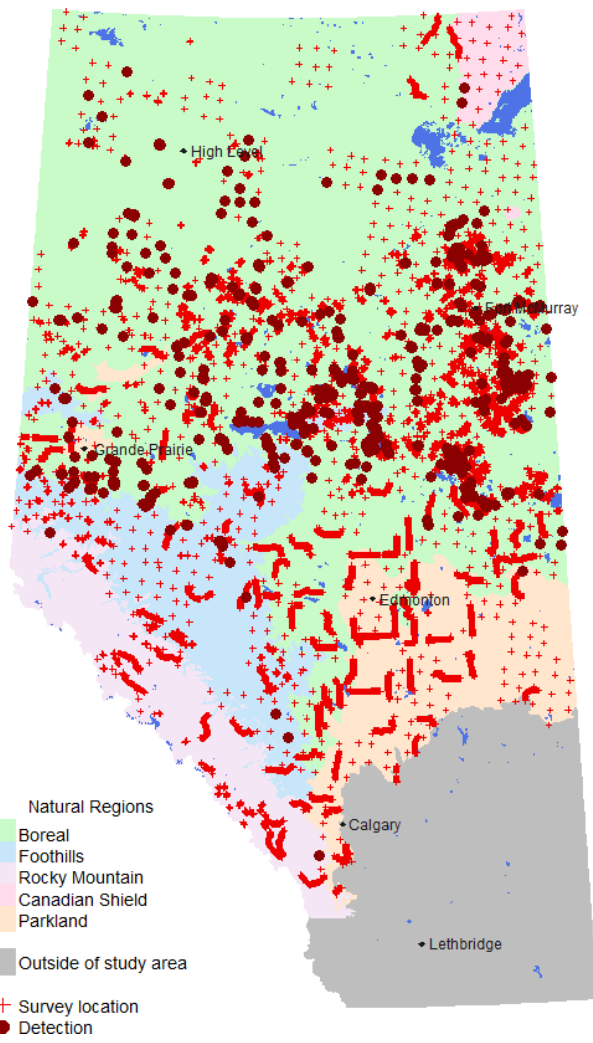
Fig. 1 . The spatial distribution of survey locations and Canada Warbler detections within the northern Alberta study area used to model habitat associations and